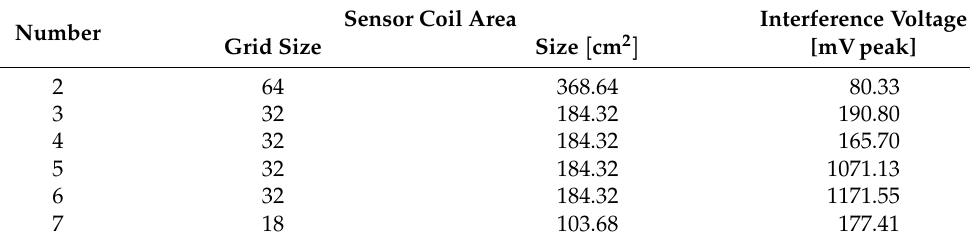
Table 6. Interference voltage capacitively coupled into different sensor